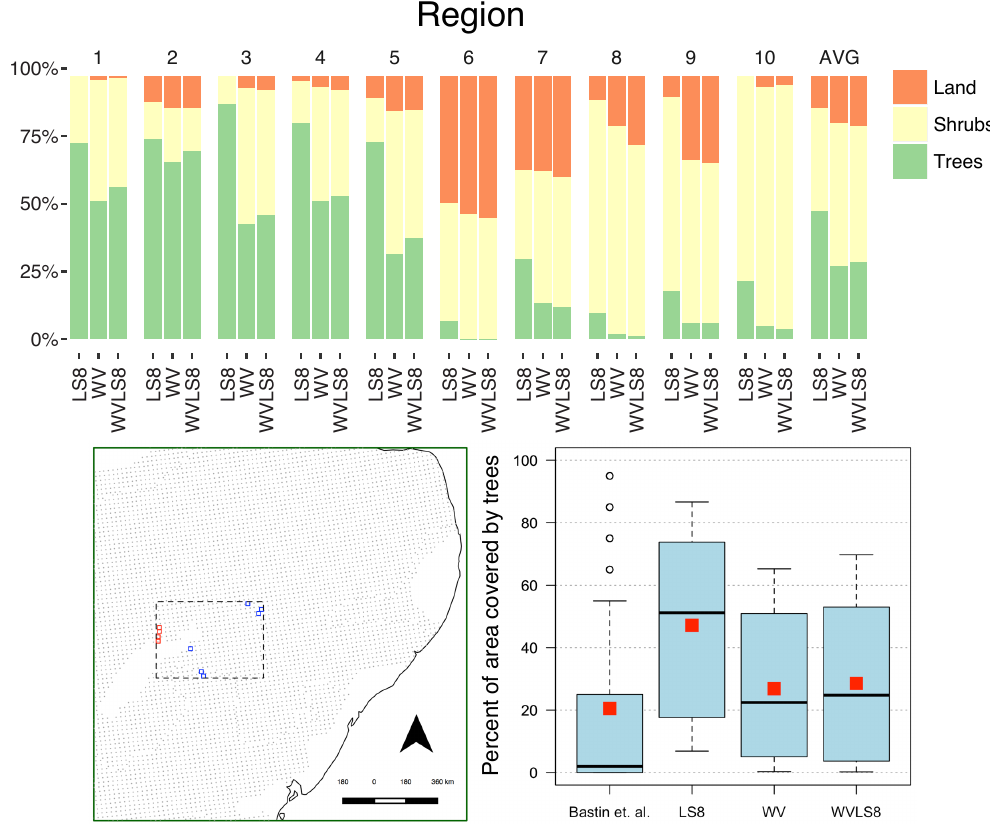
Figure 9. ( top panel ) Full area estimates, showing percentage of each region covered by each class, per classifier. Note: for full classification of each 1000 km 2 region we used the labeled examples from within that region as a training set. Corresponding values shown in Table A8. ( bottom panels ) Comparison of results for our pixel-based method using high spatial resolution data to Bastin et al.’s results [10] using a sampling and image interpretation approach. Box and whisker plots show the percentile distributions; red squares correspond to mean values. Our high resolution classifiers (WV and WVLS8) estimate a much larger average fraction of tree cover, when comparing our 1000 km 2 area (10 sample regions) to Bastin et al.’s sampled regions from the surrounding area (black dashed box). The black dashed box includes 8584 0.5 ha sampling areas, or just under 43 km 2 . The pure Landsat (LS8) classifier over-estimates treecover, due to a relative inability to distinguish trees from seasonal shrubs and grasses. (A table version of the full area estimates can be found in Appendix